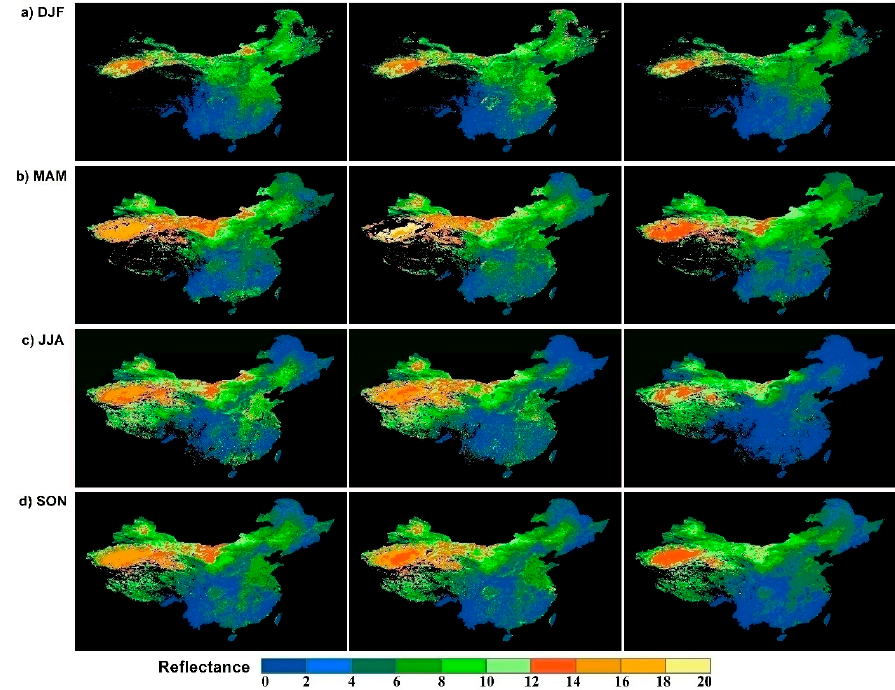
Figure 5. Comparisons of three seasonal maps of surface reflectance at 0.47 µm obtained from the Simplified AtmospHeric correction AlgoRithm for gAofen data (SAHARA) coefficients ( left ), MOD09 ( middle ), DB coefficients ( right ) respectively. ( a – d ) are the comparison of DJF, MAM, JJA, and SON respectively. Remote Sens. 2017 , 9 , 253